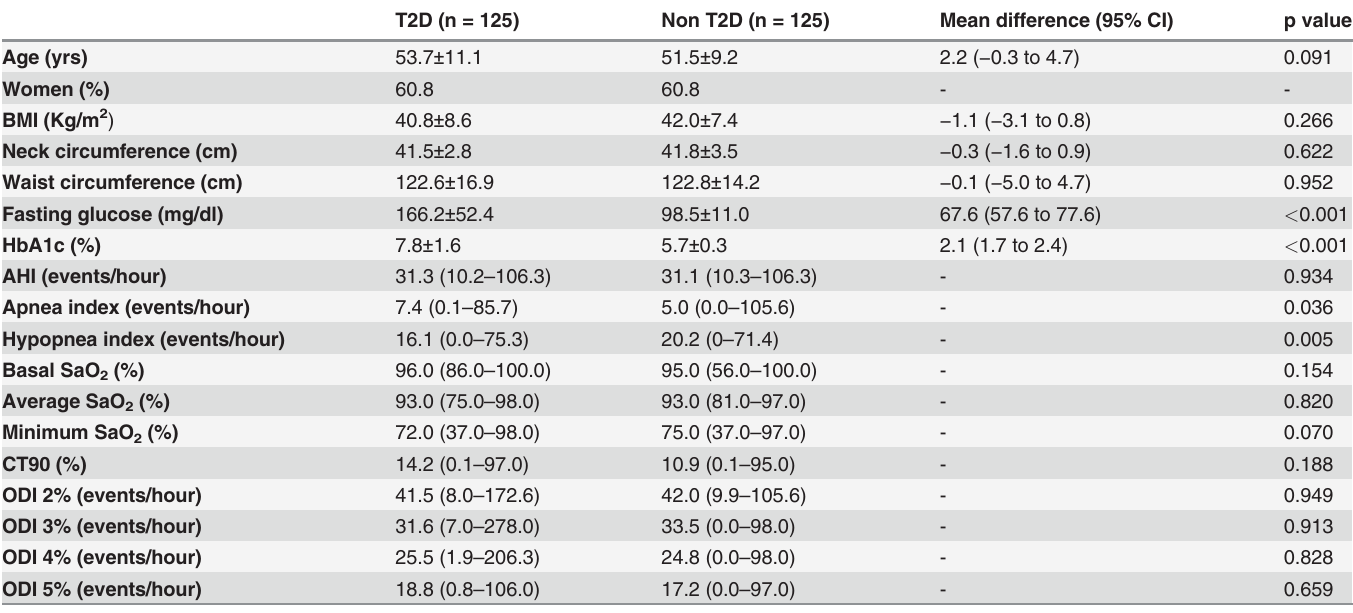
Table 3. Main clinical characteristics, metabolic data, and pulmonary parameters when patients with T2D and subjects without diabetes are matched not only by age, gender, BMI, and neck and waist circumferences, but also by